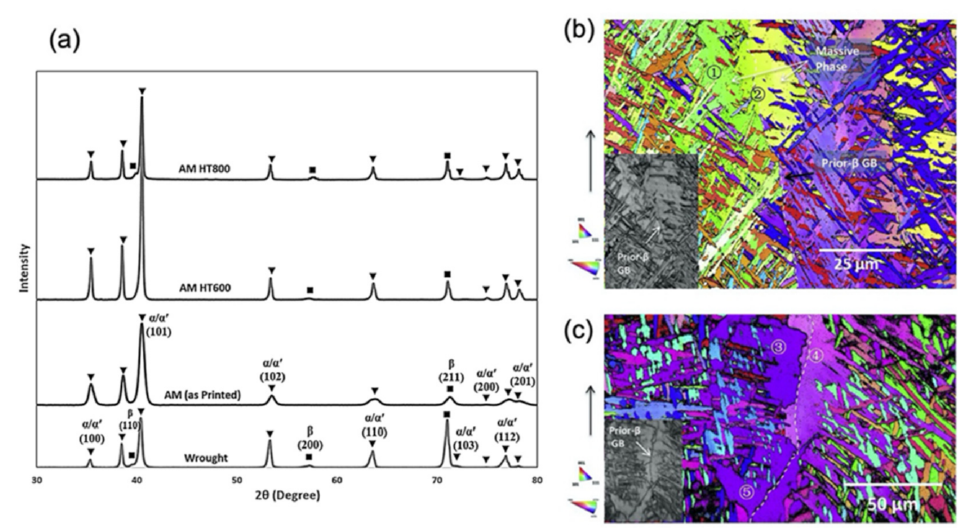
Figure 5. ( a ) XRD data for both AM and wrought Ti6Al4V indicates the sole presence of α ’ marten- site within AM samples [59]. ( b , c ) EBSD color inverse pole from figures of EBM-printed Ti6Al4V samples